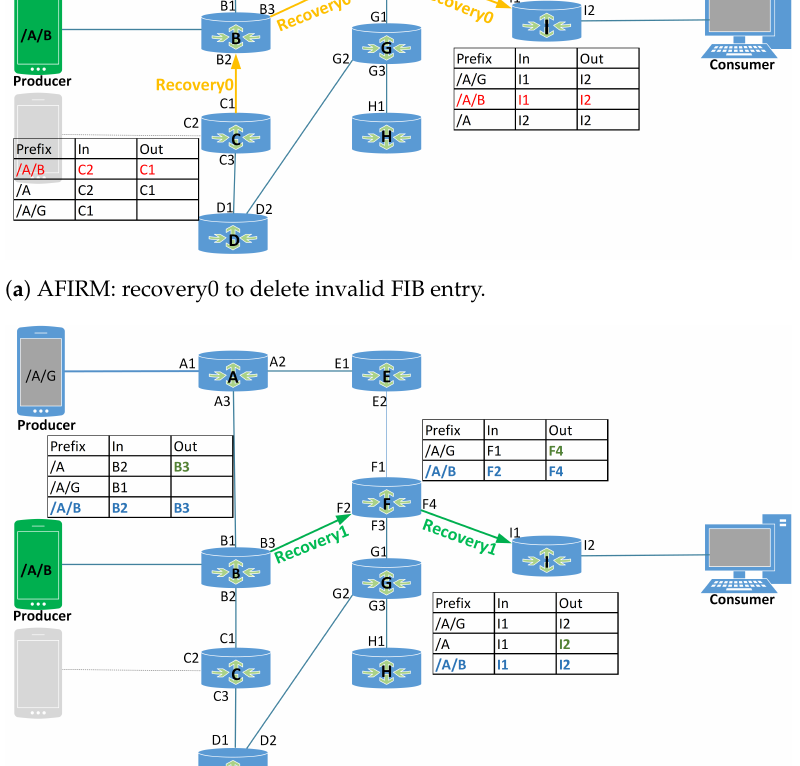
Figure 2. Example of AFIRM